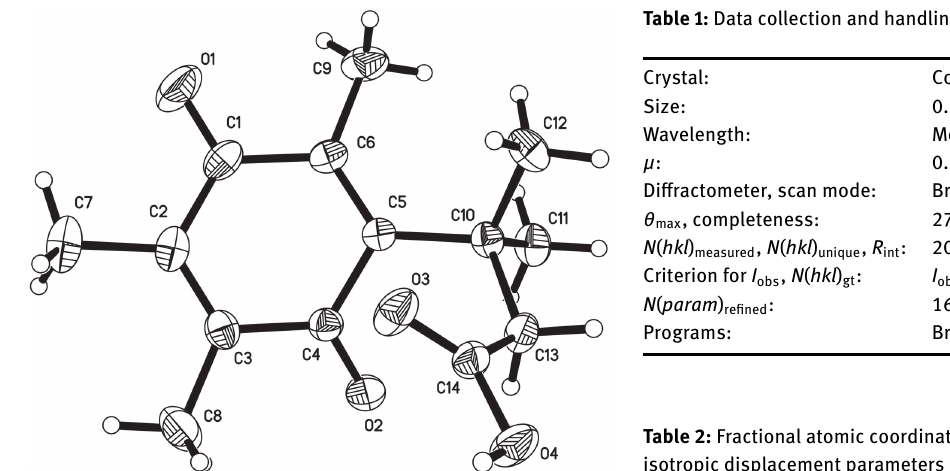
Table 2: Fractional atomic coordinates and isotropic or equivalent isotropic displacement parameters (Å 2